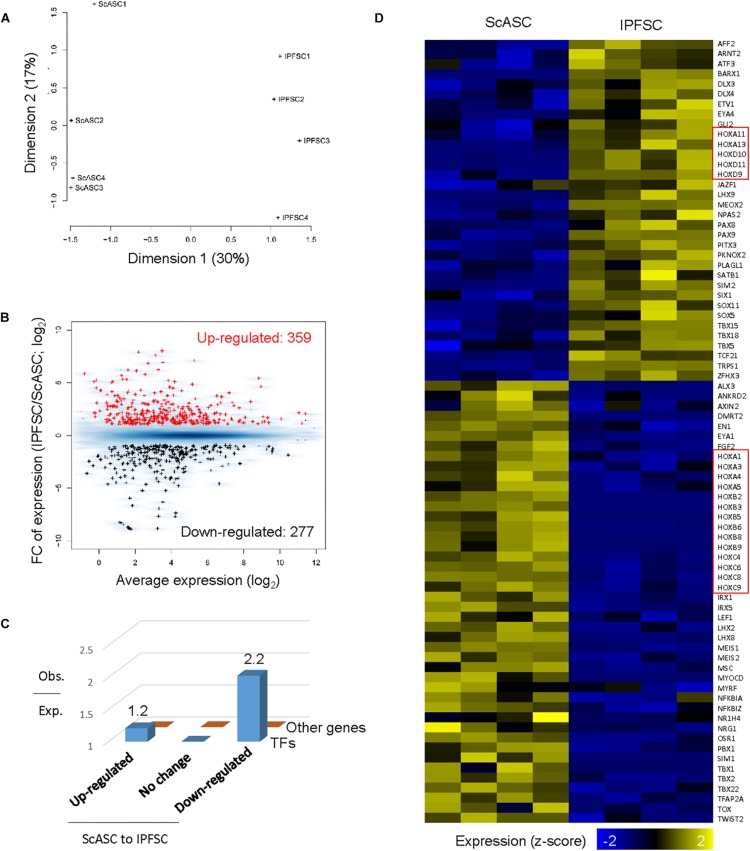
Differentially expressed gene analysis of ScASCs and donor-matched IPFSCs from four rabbits (n = 4). (A) Principal coordinates analysis on gene expression for RNA-Seq samples from ScASCs and IPFSCs. (B) MA plot showing the average and fold change (FC) of gene expression for differentially expressed genes between ScASCs and IPFSCs. Red: genes upregulated from ScASCs to IPFSCs; Black: genes downregulated from ScASC to IPFSCs; Blue background: all expressed genes. (C) Bar plot showing the ratio of observed number to the expected number of genes for transcription factor genes and for other genes grouped based on their expression changes between ScASCs and IPFSCs. (D) Heat map showing the expression changes between ScASCs and IPFSCs for differentially expressed transcription factors. Genes sorted first by their expression changes and then by names. Red rectangles: Homeobox (HOX) genes.